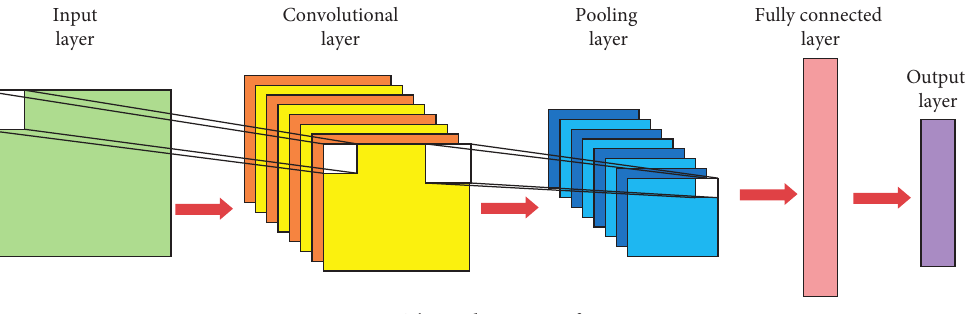
Figure 3: The architecture of CNN.